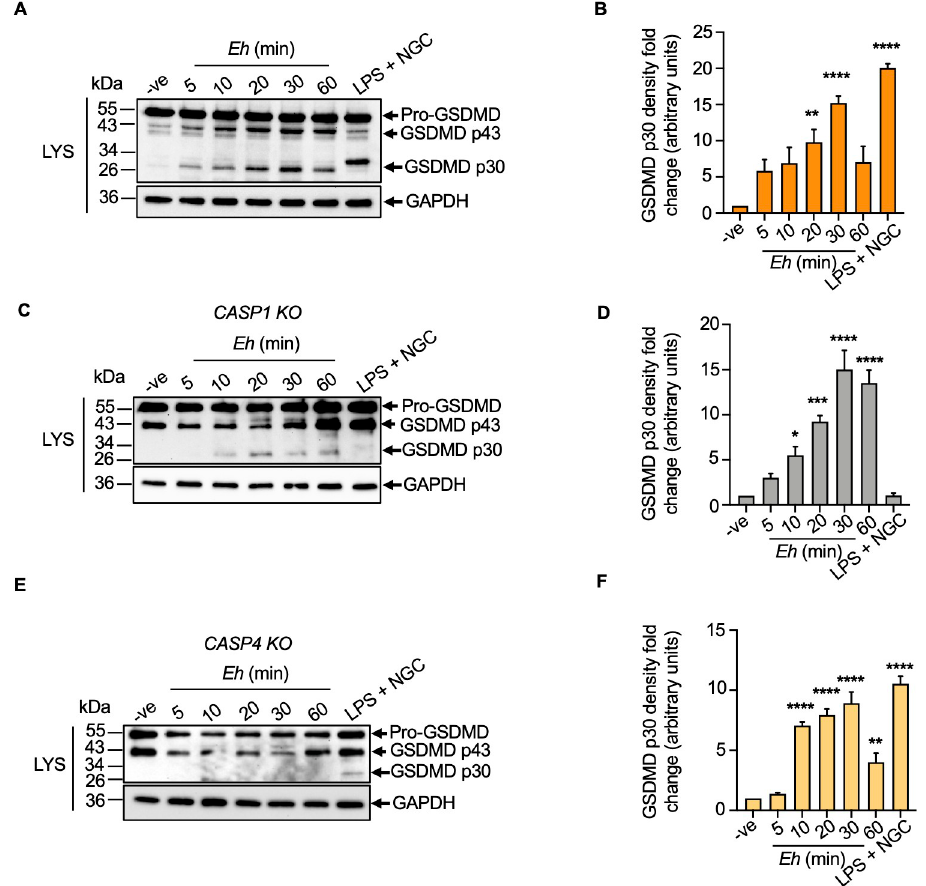
Fig 6. E . histolytica activates caspase-4 and caspase-1 in a time-dependent manner and cleaves gasdermin D to regulate IL-1 β secretion. ( A, C, E ) WT, CRISPR/Cas9 CASP1 KO , and CRISPR/Cas9 CASP4 KO macrophages were incubated for increasing amounts of time with 1:20 Eh to macrophage ratio. LPS (50 ng/mL) and NGC (10 μ M) for 60 min acted as a positive control. Cells were washed, lysed and equal amount of lysates (LYS) was loaded onto SDS-PAGE and immunoblot analysis was performed for GSDMD cleavage that present in cell lysates. ( B, D, F ) Quantifications of GSDMD p30 protein were performed by densitometric analysis and blots were reprobed for GAPDH. Negative cells only acted as an internal control. Data and immunoblots are representative of at least three independent experiments (n = 3) and statistical significance was calculated using with an ANOVA and Bonferroni’s post-hoc test ( � p < 0.05, �� p < 0.01, ��� p < 0.001, ���� p < 0.0001). Bars represent mean ±